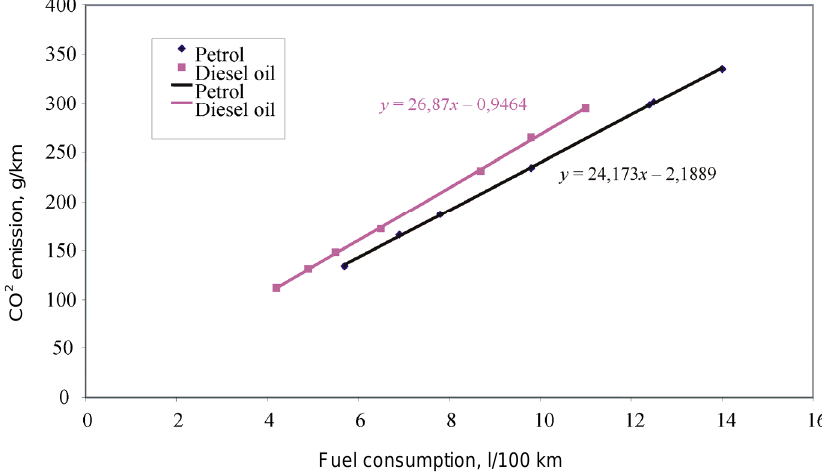
Fig 2. The relationship between CO 2 emission and fuel consumption of a motor car